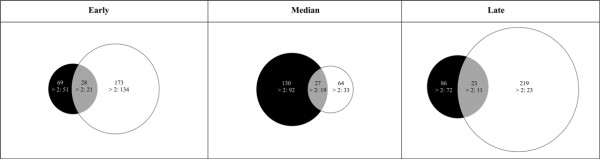
Characterisation of the transcriptomic response. A; Venn diagram representing mRNA transcripts differentially expressed over control during PGN-O111:B4 and PGN-K12 challenges throughout the time (early, median and late stage). The area of the circles is scaled to the number of transcripts (one way ANOVA p < 0.01) and the fold change (FC >2) expressed in each stage. Black circles: 69, 130, 86 number of transcripts differentially expressed under PGN-O111:B4 treatment. White circles: 173, 64, 219 number of transcripts differentially expressed under PGN-K12 challenge.